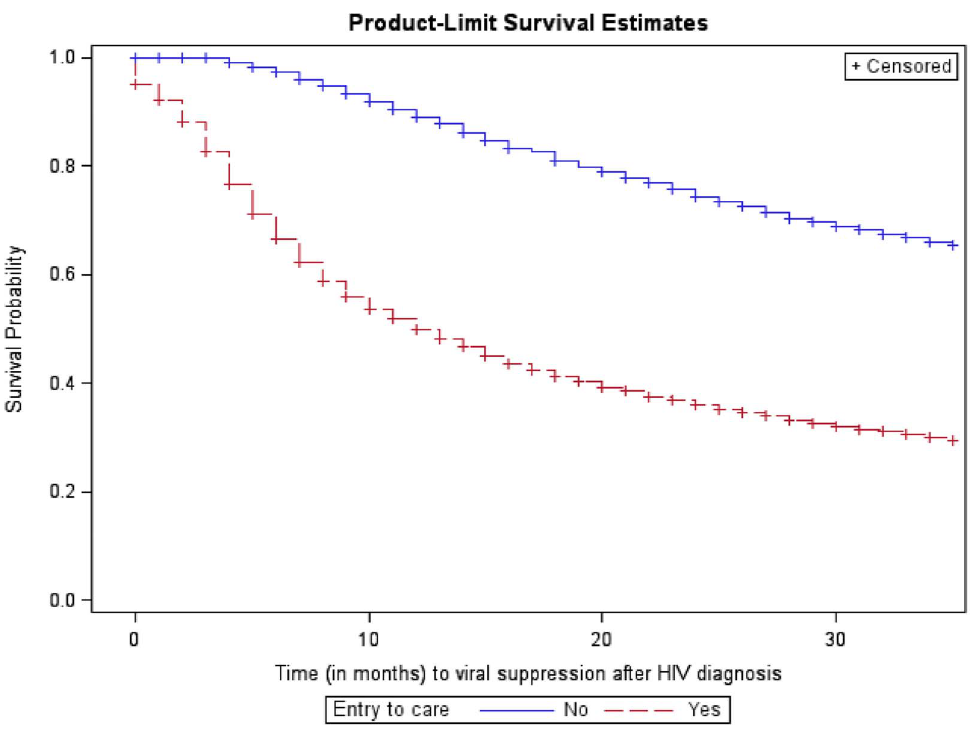
Figure 1. Kaplan-Meier survival curve for time from HIV diagnosis to viral suppression, by entry to care within 3 months of HIV diagnosis.